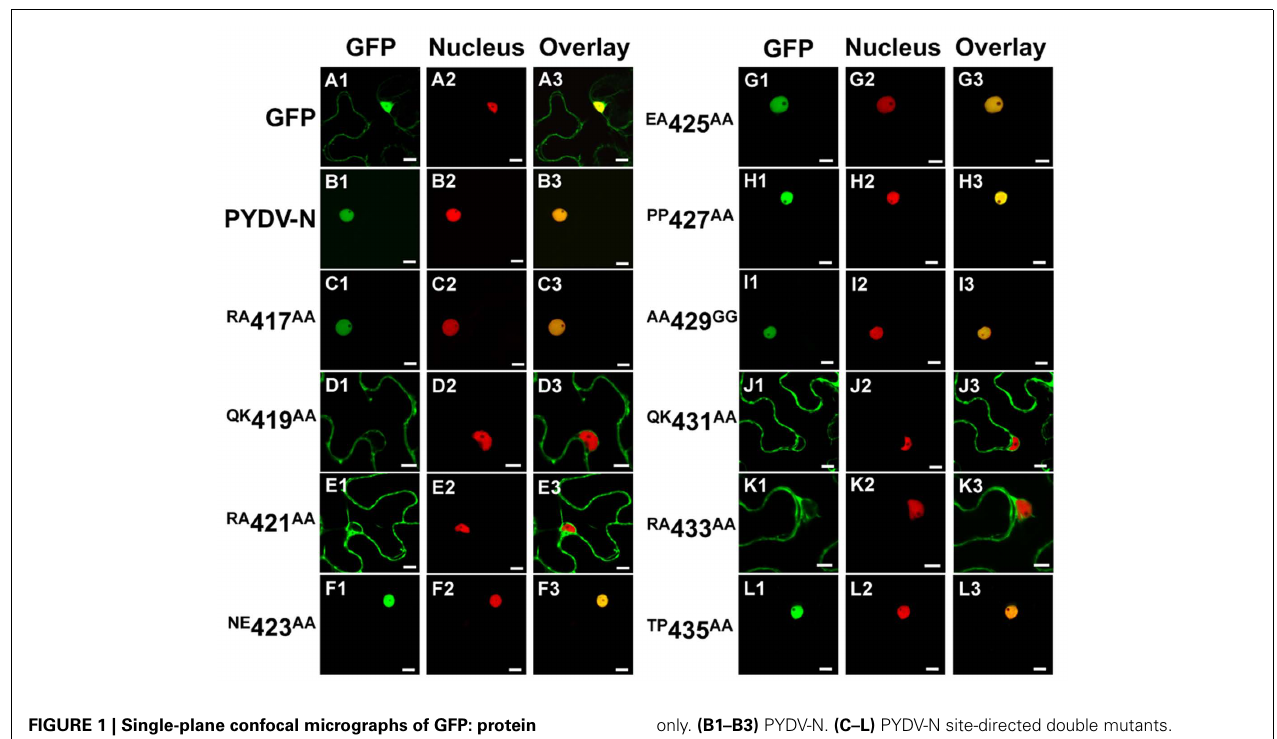
FIGURE 1 | Single-plane confocal micrographs of GFP: protein fusions expressed transiently in leaf epidermal cells of N. benthamiana plants transgenic for the nuclear marker, RFP: histone 2B. Shown in panels 1, 2, and 3 are micrographs of GFP (fusions), RFP, and the resultant overlay, respectively. (A1–A3) GFP